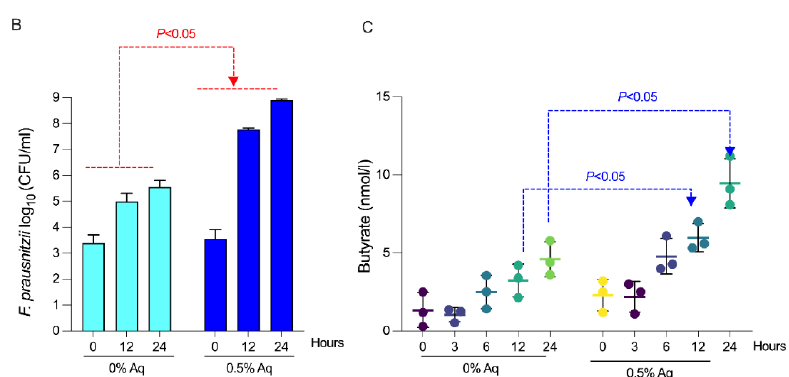
Figure 2. F. prausnitzii growth, relative to total bacteria as quantified by RT-PCR in an in vitro gut model with shrimp faeces. Panel ( A ) shows the ratio of F. prausnitzii abundance relative to total bacteria abundance. Panel ( B ) indicates the growth profile of F. prausnitzii in the presence of 0.5% Aq in an irradiated shrimp gut model. The graph shows the mean ( ± SEM; for time 12 and 24 h) log 10 (CFU/mL) of the bacteria at 12 and 24 h of incubation with 0.5% Aq. Panel ( C ) presents the levels of butyrate released by F. prausnitzii in the irradiated shrimp gut model and the effect of 0.5% Aq. Butyrate production was measured at intervals of 0, 3, 6, 12 and 24 h. All experiments were performed triplicate and each measurement was performed from three separate samples. A P value less than 0.05 was considered significant.